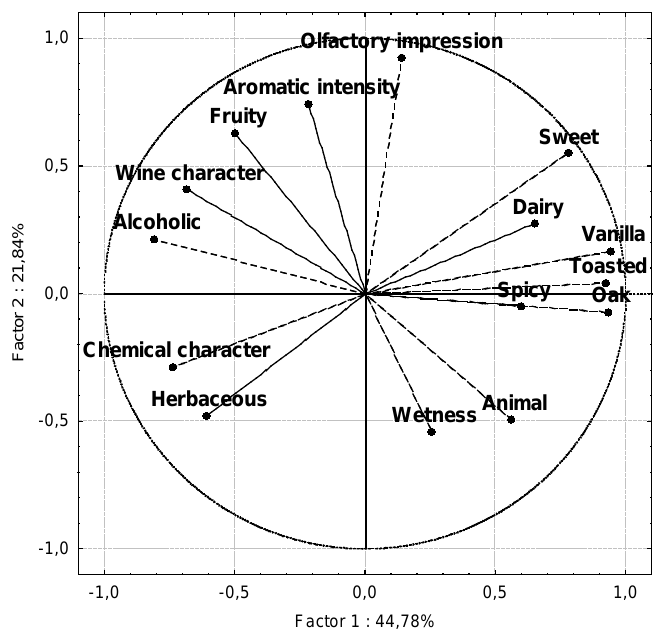
Figure 8. Principal component analysis of sensory data. Projection of the variables on the factor plane.